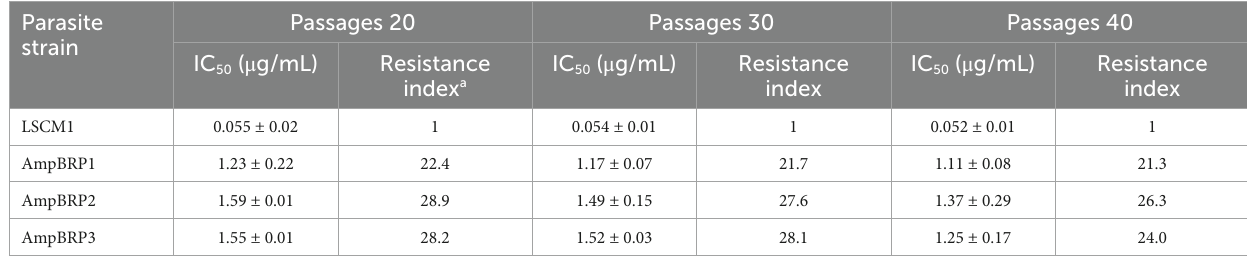
TABLE 1 Promastigote susceptibility to AmpB for L. martiniquensis LSCM1, and in vitro derived AmpBRP clones after removal from drug pressure. Results are expressed as mean ± SD based on three independent replicates. Parasite strain